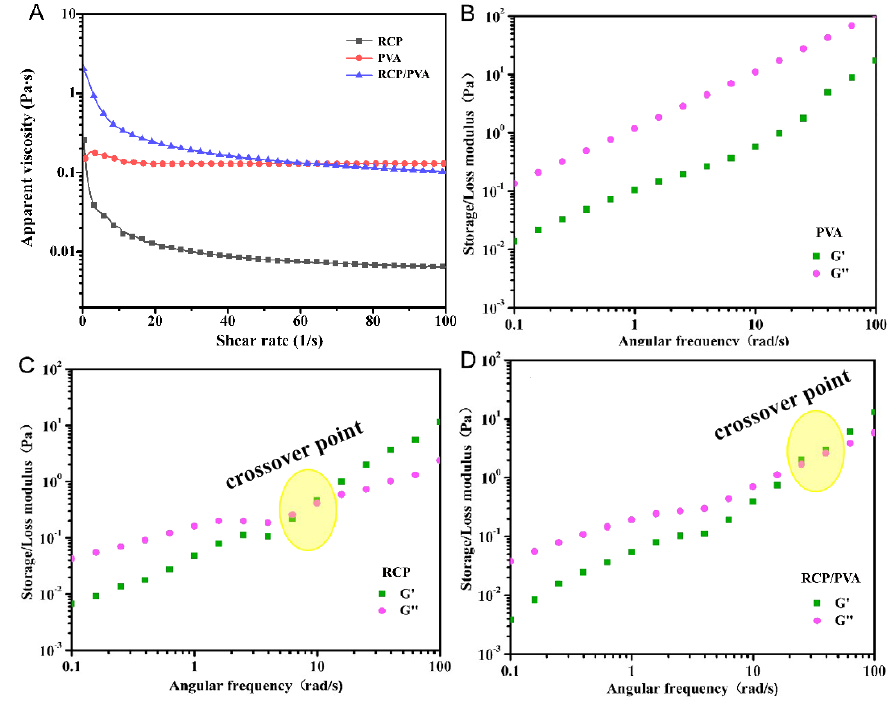
Figure 2. Steady ( A ) and dynamic ( B – D ) rheological properties of the